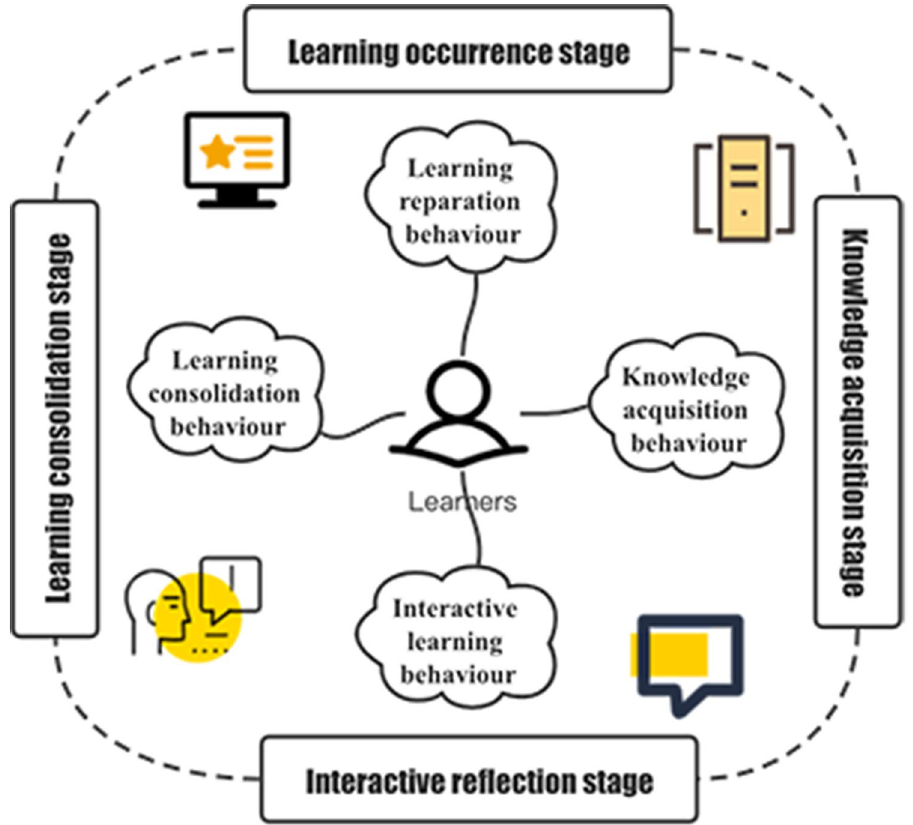
Figure 2. The process-behaviour classification model